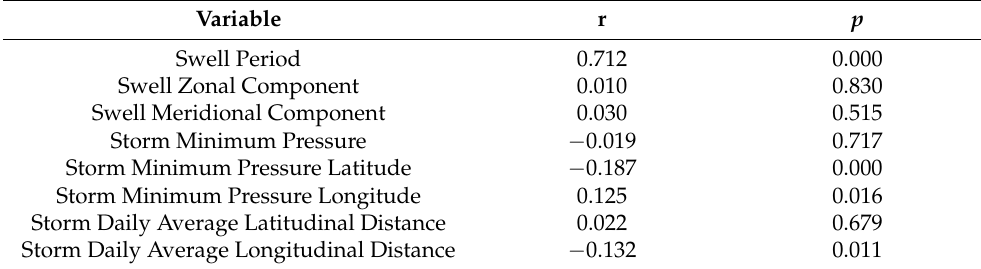
Figure 13. Average storm tracks based on the individual tracks shown in Figure 12. The dotted rectangle is the area used to constrain the storm identification algorithm. Red, green, and blue tracks are for storms that generated swells of different probabilities in the eastern Caribbean study area. Gray-scale tracks are for storms of different probabilities that did not generate north swells in the eastern Caribbean study area. p25, p25–75, and p75 are swell or storm probabilities <0.25, 0.25–0.75, and >0.75, respectively. n represents the number of storms that were used to create the average track. t is the direction of the average track, where 0° represents south to north and increases clockwise. beg and end represent the average locations on the first and last days that the storm was identified by the algorithm. avg is the average location for all days of the averaged storm tracks and minP is the average location where the storm sea level pressure was lowest. Table 2. Pearson correlation coefficients r and corresponding p -values for relationships between spatially averaged maximum swell heights for north swell events in the eastern Caribbean study area on the one hand, and the three swell (period, zonal, and meridional components) or storm (minimum pressure, latitude and longitude of minimum pressure, and average daily distance traveled) variables on the other hand.